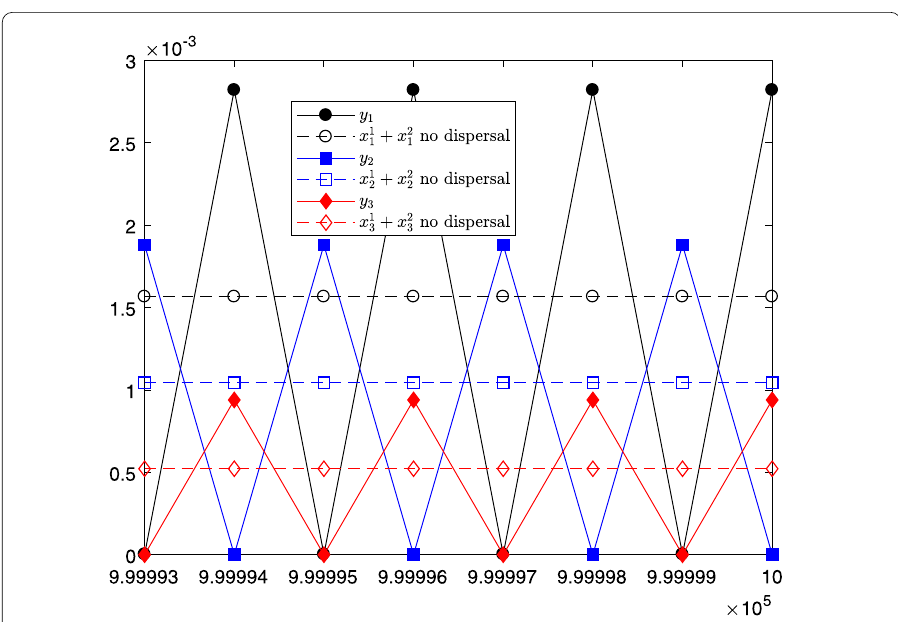
Figure 4 Changing local reproductive asynchrony into global reproductive synchrony. Change from local reproductive asynchrony to global reproductive synchrony in the adults reproductive behavior when going from the local level (isolated identical patches that have dynamics defined by matrices (28)) to the global level (represented by system (29)) when we incorporate dispersal. Parameter values: s 1 = s 2 = s 3 = 0.5, c = 1, d = 5.5, 1 1 φ = 3.0003, v 1 1 = 0.3, v 2 = 3/8, v 3 = 1/8. Initial conditions are X (0) = (0.02,0.02,0.05,0.05,0.02,0.02). The simulations have been run until time t = 10 6 and only the last 8 times are